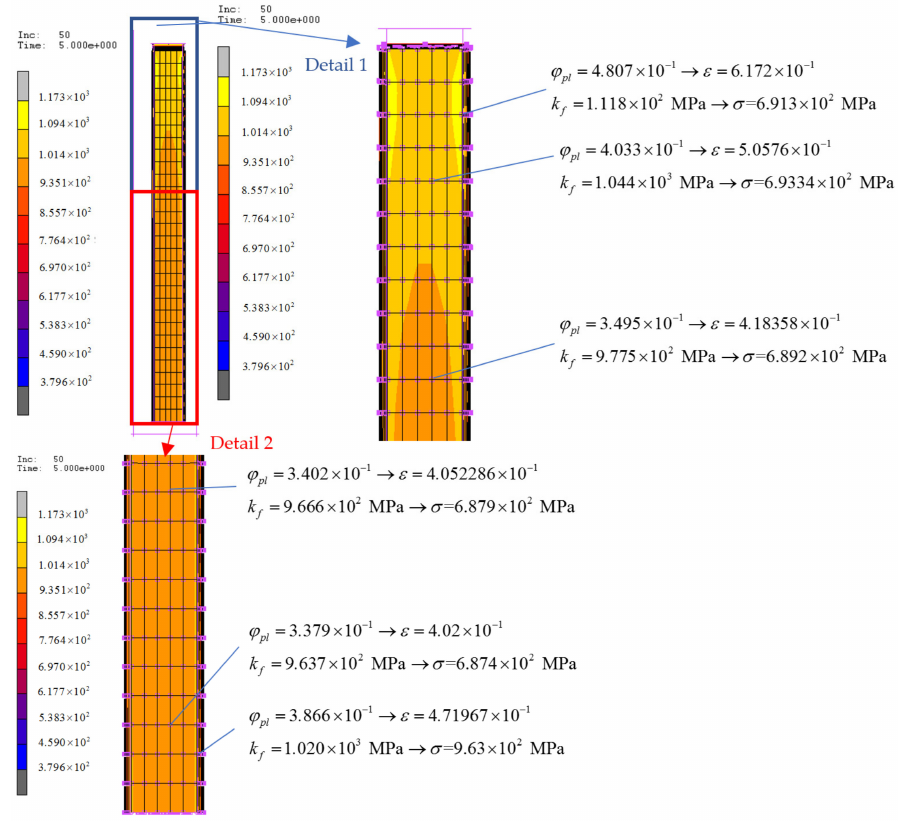
Figure 19. True stress distribution at the specimen (side